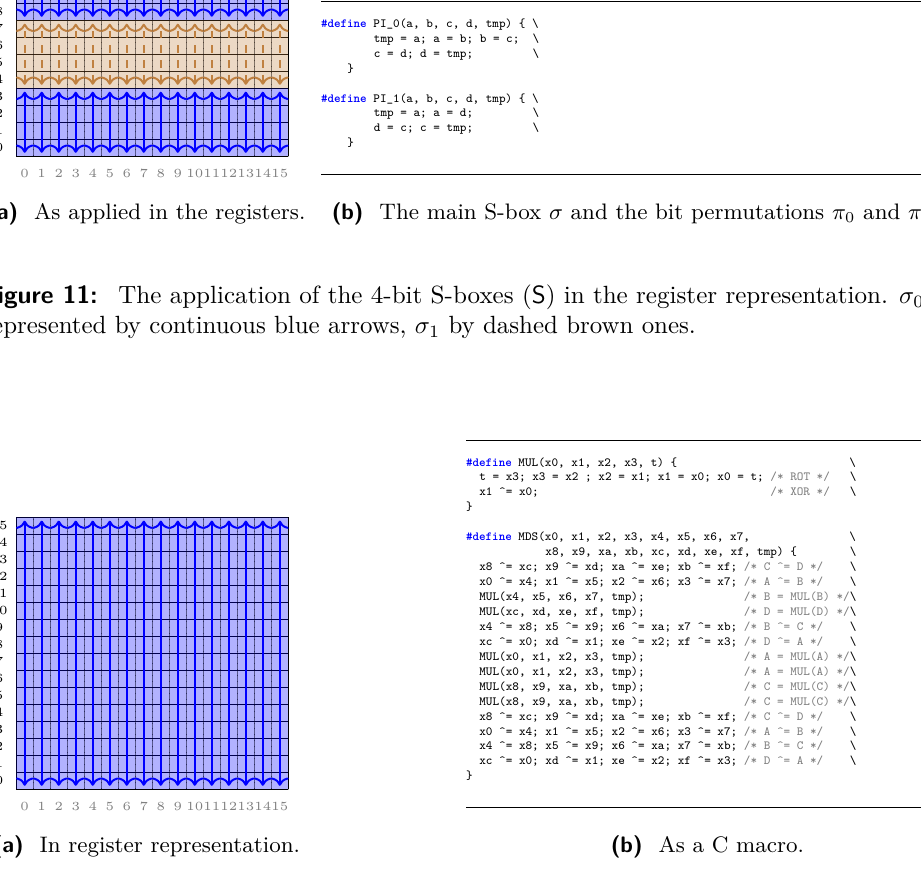
Figure 12: The parallel application of the 16 × 16 matrix 𝑀 , i.e. the operation MC